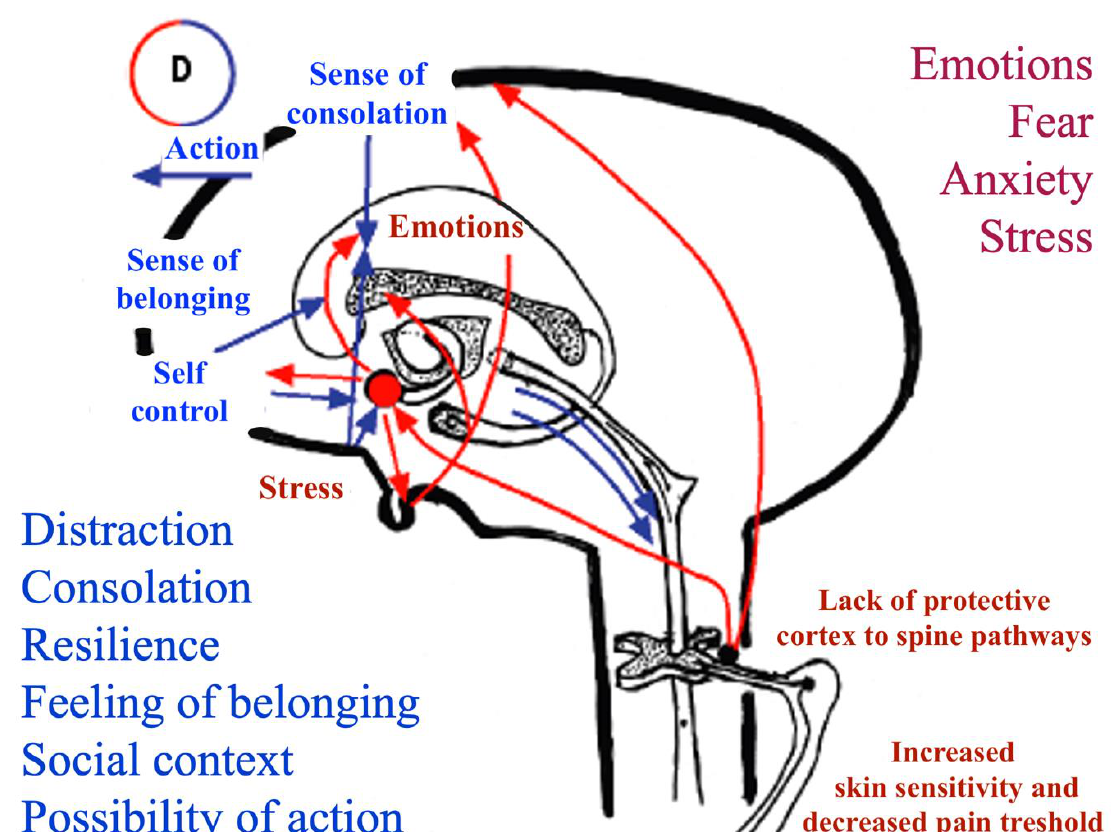
Figure 1. Pain and antinociceptive system pathways. Pain amplification (red) and control (blue) factors. Modified from Panizon and Barbi. Some Specific Issues on Pain in Pediatrics: Summary and Review of the Present Knowledge and Practice. Medico e Bambino, 2010; 29:289-297. See also Reference [7].